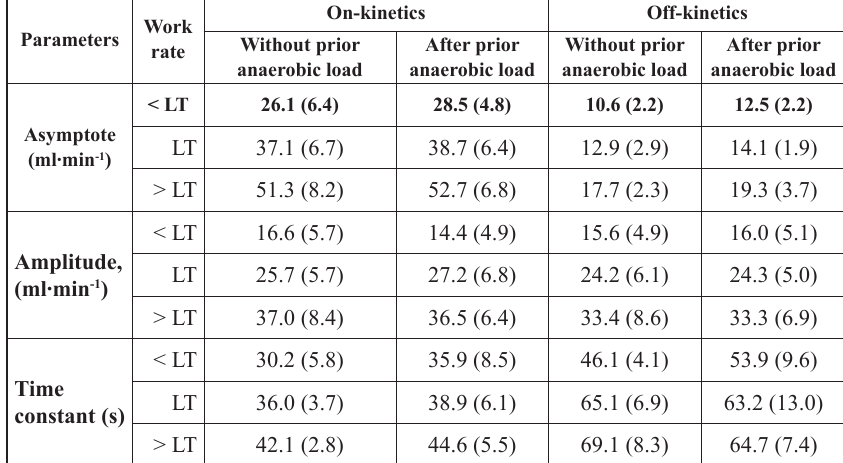
3. Parameters of V E changes during on- and off-transition periods of intermittent increasing exercise without and after